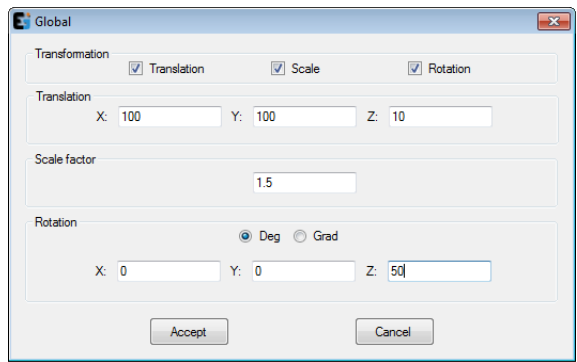
Figure 12. Global transformation in 3DVEM – GEO For instance, the constant values presented in Fig. 12 correspond to the values required to rotate 50º around the Z axis, scale 1.5 times the input data, and move a 3D point cloud/model to the global position (100, 100,